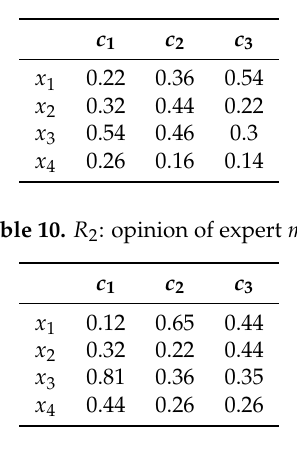
Table 9. R 1 : opinion of expert m 1 .